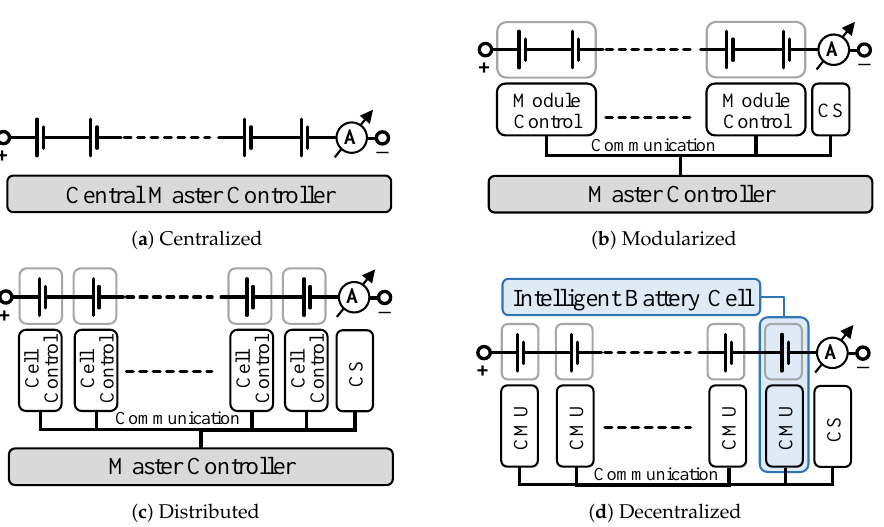
Figure 10. Visualization of different BMS architectures based on [530,560] and their occurrence in literature. ( a ) centralized [561]; ( b ) modularized [554,557,562]; ( c ) distributed [9,401,461,527,555,563–567]; ( d ) decentralized